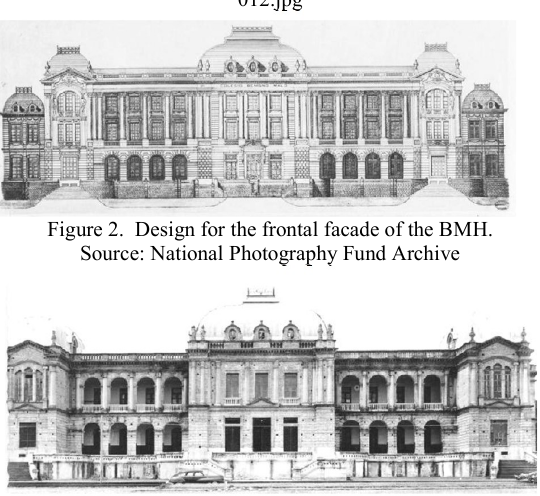
Figure 3. Executed Project. Changes considerably the architectural language in the second floor. Table 1. Sample of respondents of the on-line